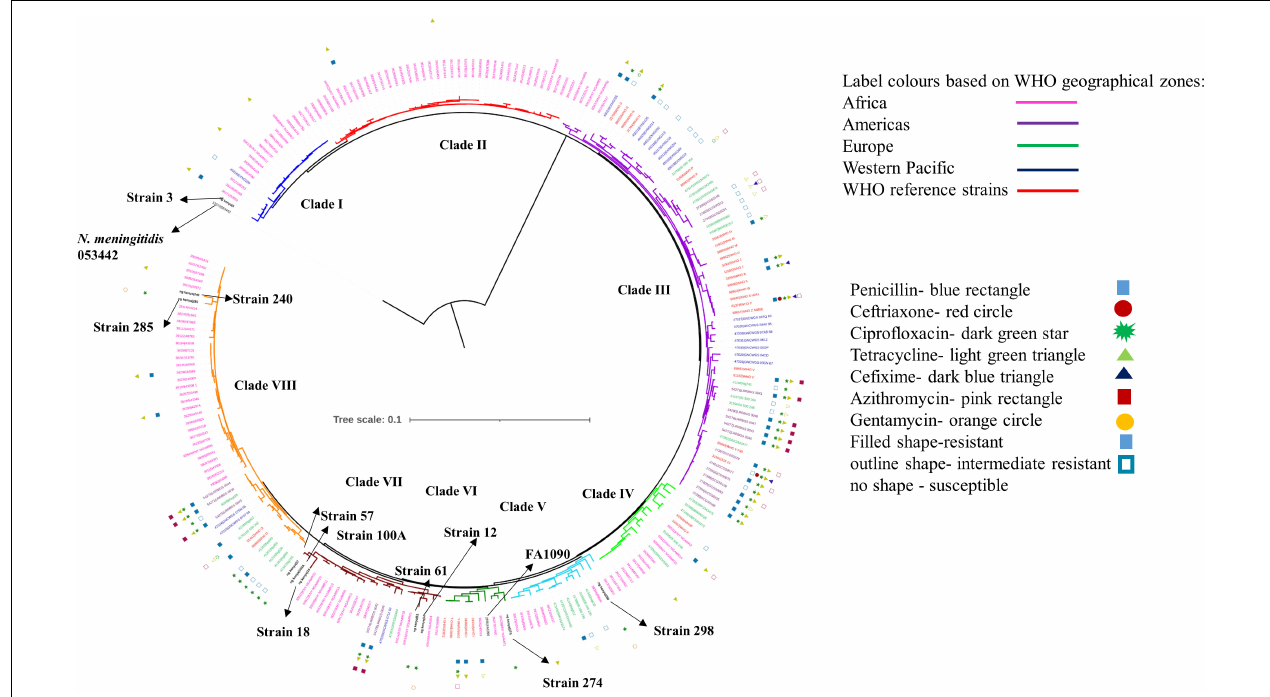
FIGURE 1 | Phylogenetic tree of the sequenced strains with strains from WHO geographical regions and WHO reference strains. The strains sequenced in this study have been indicated in black, bold text in the tree. The antibiotic resistance profile, wherever available, has been indicated as metadata (Penicillin – blue rectangle, Ceftriaxone – red circle, Ciprofloxacin – dark green star, Tetracycline – right-pointing light green triangle, Cefixime – left-pointing dark blue triangle, Azithromycin – pink rectangle, Gentamycin – orange circle, Filled shape – resistant, outline shape – intermediate resistant, no shape – susceptible). The clades inferred from the phylogeny analysis have been indicated in different colors and numbered I–VIII. The strains from different WHO geographical regions have been indicated in different color labels (Africa – Pink, Americas – Magenta, Europe – Green, Western Pacific – Blue, WHO reference strains – Red) The strains sequenced in this study, the reference strain for N. gonorrhoeae (FA1090), and an N. meningitidis strain (PubMLST id:053442) used as an outgroup for the analysis have been labeled and indicated with